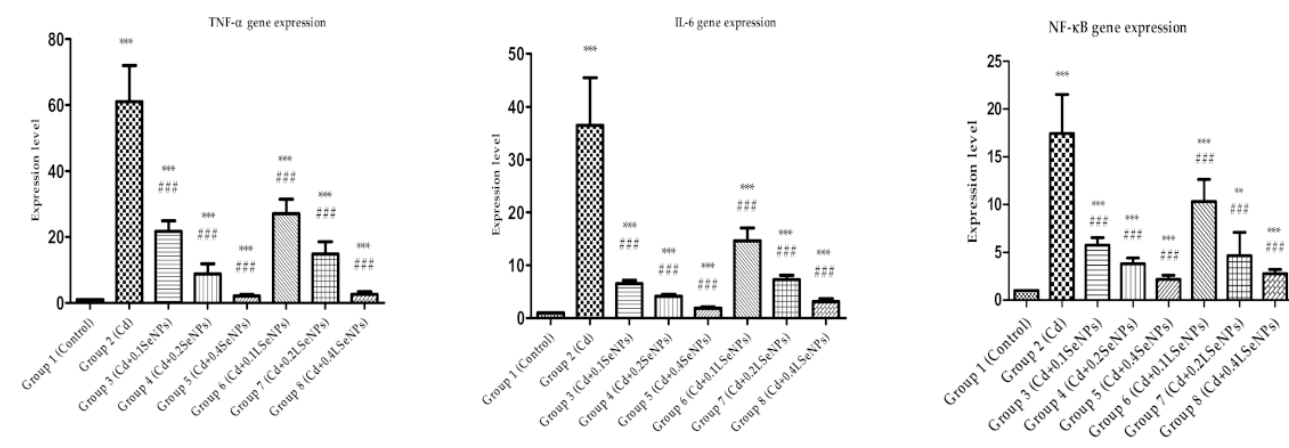
Figure 8. Hepatic TNF- α , IL-6, NF-kB p65 gene expressions. *** p < 0.001, ** p < 0.01 compared to control, ### p < 0.001 compared to Cd group. Groups: 1—control; 2—CdCl 2 ; 3—CdCl 2 + 0.1 mg/kg SeNPs; 4—CdCl 2 + 0.2 mg/kg SeNPs; 5—CdCl 2 + 0.4 mg/kg SeNPs; 6—CdCl 2 + 0.1 mg/kg LSeNPs; 7—CdCl 2 + 0.2 mg/kg LSeNPs; 8—CdCl 2 + 0.4 mg/kg